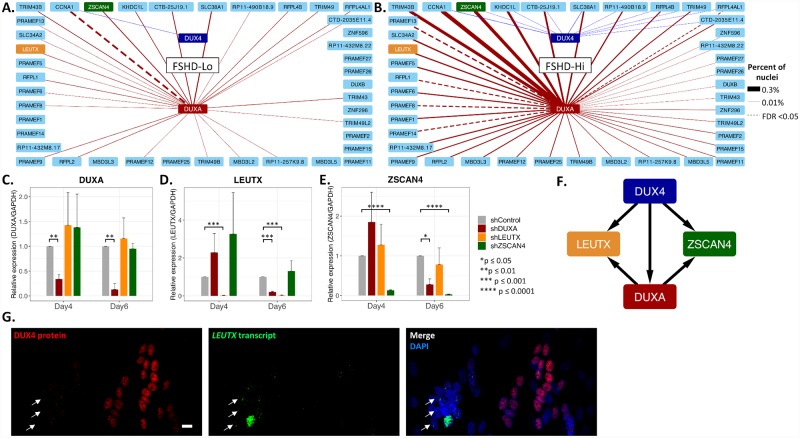
DUXA regulates FSHD-induced genes.Coexpression network of 41 FSHD-induced genes which are coexpressed with DUX4 and/or DUXA in (A) the ddSeq FSHD-Lo population and (B) the ddSeq FSHD-Hi population. Line thickness is the percent of nuclei coexpressing the two genes. Red lines represent coexpression with DUXA. Blue lines represent coexpression with DUX4. Dashed lines indicates FDR <0.05 using Fisher’s exact test. (C-E) RT-qPCR analyses of the effects of lentiviral shRNA depletion of three DUX4 target transcription factors. Relative RNA expression of (C)
DUXA, (D)
LEUTX, and (E)
ZSCAN4 on days 4 and 6 of differentiation in FSHD2-2 cells following depletion of each gene product as indicated is shown. Expression measured by qPCR, and values are normalized to GAPDH expression and the non-targeting shControl. Significance calculated with t-test, and n = 3 for each condition. All significant differences are marked by asterisks. Color indicates the shRNA used as listed on the right. (F) Proposed model for DUXA regulating FSHD-induced genes in addition to DUX4. (G) Expression of DUX4 protein and its downstream target gene are not always concordant. Immunofluorescence detection of DUX4 protein (red) and RNAScope for LEUTX transcript (green) in FSHD2-2 day 7 myotubes. Examples of a LEUTX transcript-positive myotube with no significant DUX4 protein (left) and a DUX4 protein-positive myotube with very little LEUTX transcript signal (right) are shown. Bar, 10 μm. DAPI is in blue. Nuclei with LEUTX transcripts with no DUX4 protein are indicated by white arrows.